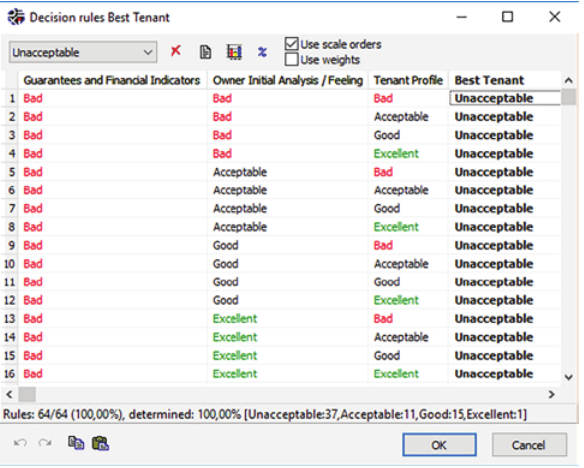
Figure 6. Utility function for Tenant Profile